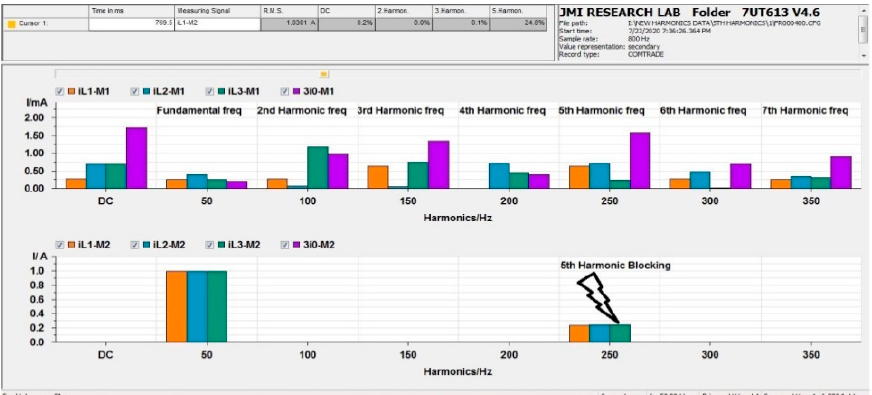
Figure 27. 5th HB at 1000 mA Rated current & 39% of Inrush current condition.